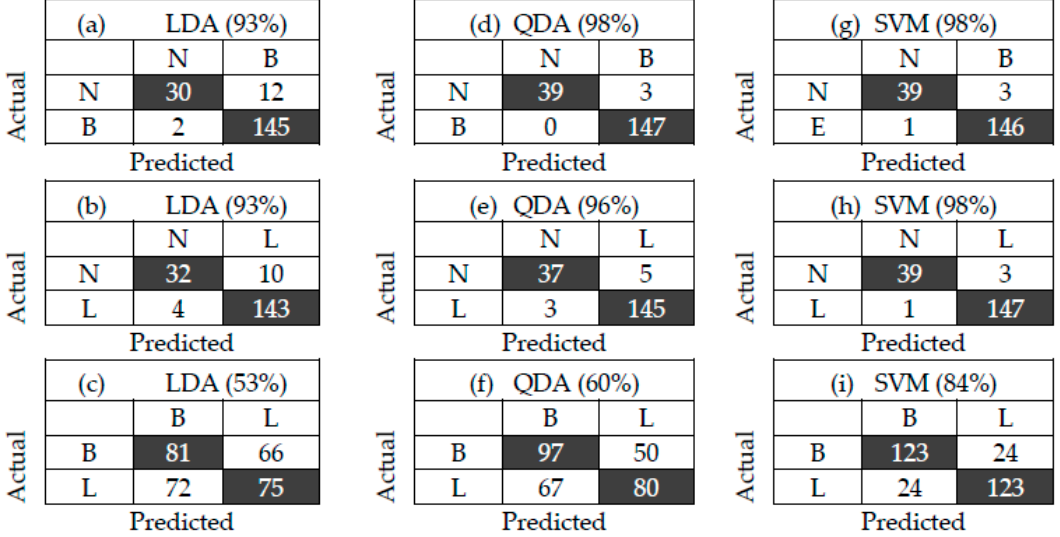
Figure 6. Confusion matrix of two groups with different chemometric models of LDA ( a – c ), quadratic discriminant analysis (QDA) ( d – f ), and support vector machine (SVM) ( g – i ). The number in parenthesis indicates the accuracy.